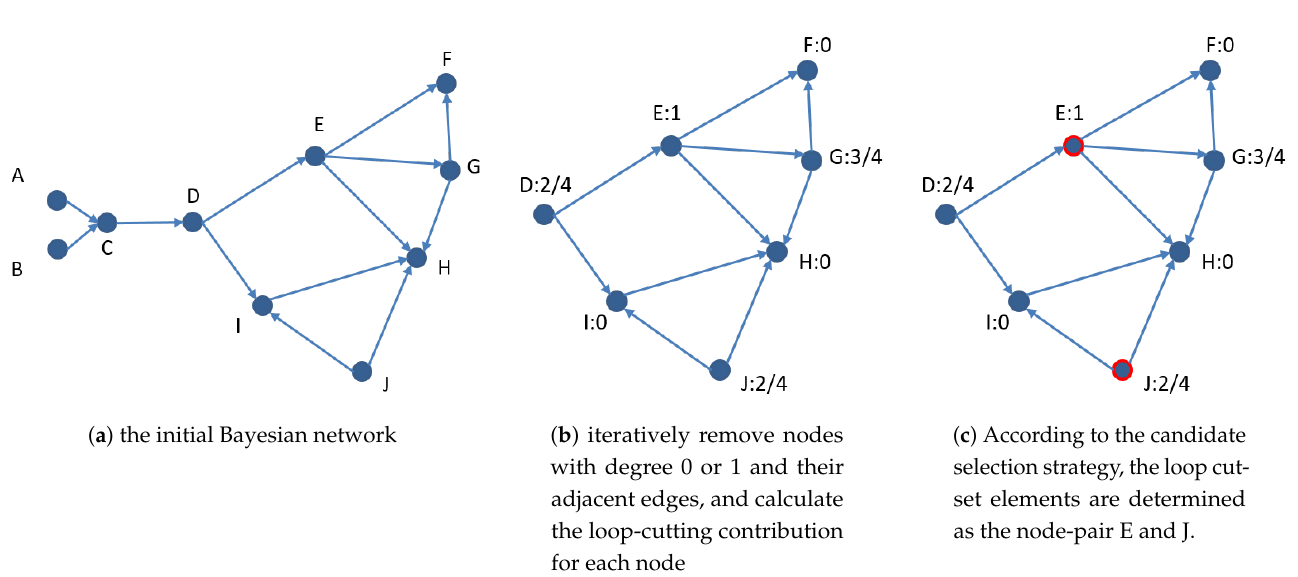
Figure 4. Apply the CFA algorithm to the Bayesian network given in Figure